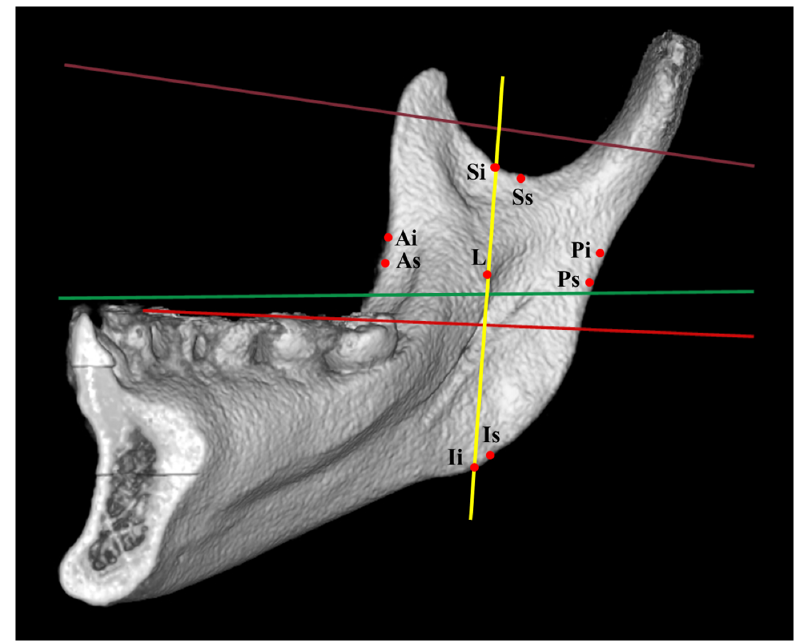
Figure 2. Reference lines: Brown line: Frankfort horizontal plane; Green line: axial plane of ramus; Red line: occlusal plane; Yellow line: vertical plane to occlusal plane. Landmarks: L: lingual, As: landmark (shortest distance) at the anterior border of ramus; Ai: intersection landmark parallel to horizontal plane at the anterior border of ramus; Ps: landmark (shortest distance) at the posterior border of ramus; Pi: intersection landmark parallel to horizontal plane at the posterior border of ramus; Ss: deepest location (shortest distance) of the sigmoid notch; Si: intersection landmark par- allel to vertical plane and through lingula at the sigmoid notch; Is: landmark (shortest distance) at the inferior border of ramus; Ii: intersection landmark parallel to vertical plane and through lin- gula at the inferior border of ramus.